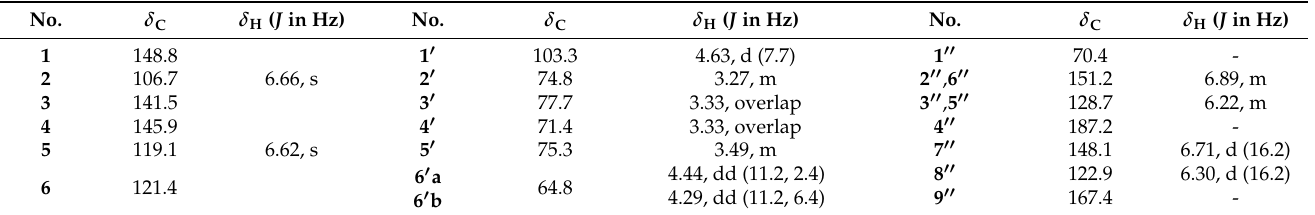
Table 2. 1 H (800 MHz) and 13 C (200 MHz) NMR spectroscopic data of compound 6 in CD 3 OD.